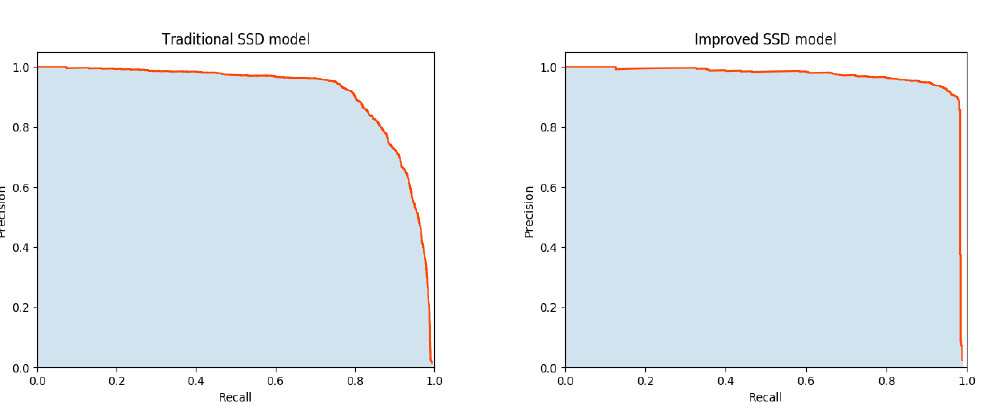
Figure 11. Comparison of P-R curves before and after model improvement.